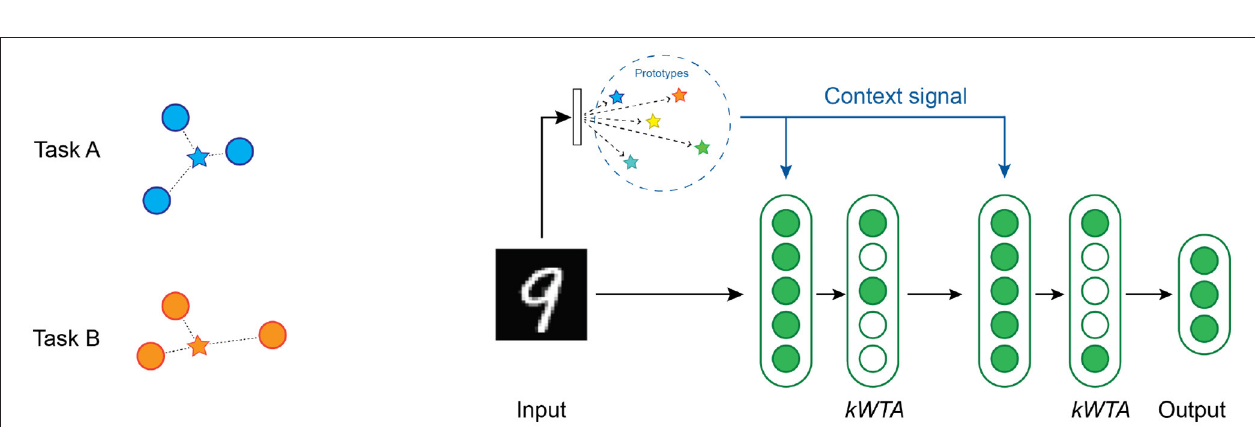
FIGURE 7 | (Left) An illustration of the prototype method for computing the context vectors. The blue circles are training samples in input space for task A, while the orange circles are training samples for task B. The blue star is a vector that represents the prototype for task A, and the orange star represents the prototype for task B. (Right) An overview of the network structure used in our continual learning experiments. There are two layers of hidden units, each with a k WTA activation function. A context vector is computed from each image by locating the nearest prototype vector.